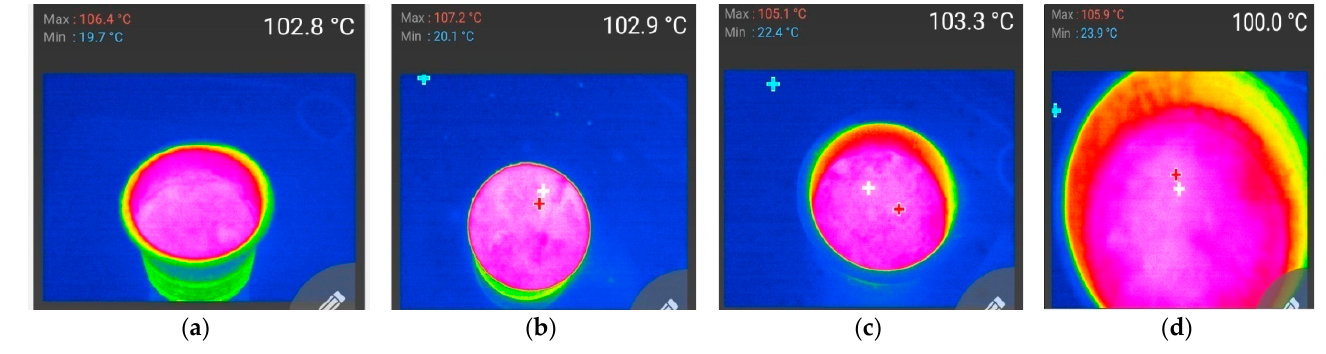
Figure 17. Thermal images: ( a ) Mode 1, ( b ) Mode 2, ( c ) Mode 3, and ( d ) Mode 4. Electrical devices facilitate the transfer of electrical currents from one circuit to another. During this energy transfer, a portion of the energy is released as heat. Copper loss is referred to as this energy loss as the heat emitted by the gadget is not utilized and just disappears into the air. Copper loss is an undesirable but currently unavoidable occurrence. This heat loss causes a negligible amount of power loss in the gadget. The copper loss for the various modes is identified through Equation (21).